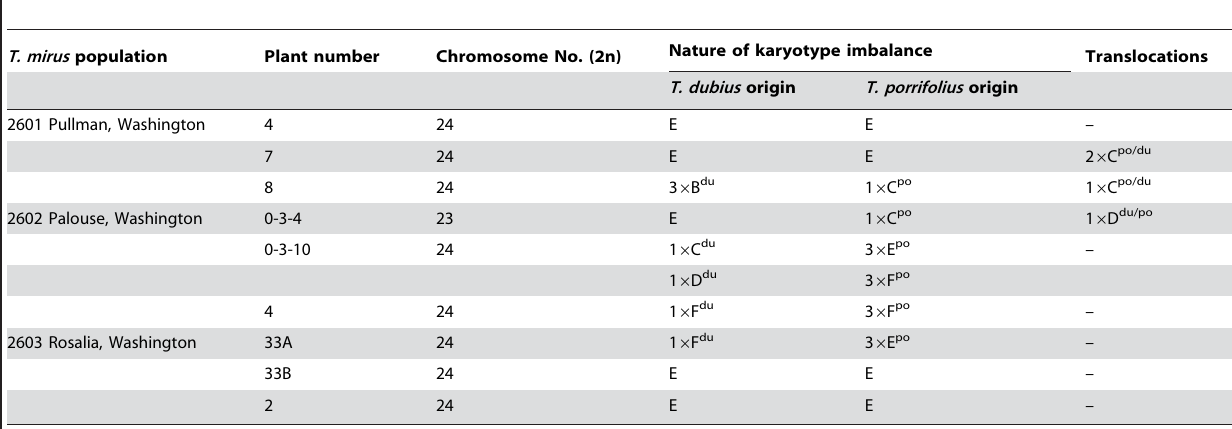
Table 1. Karyotype organisation of individuals of T. mirus from three populations (localities of each population are indicated in column 1).